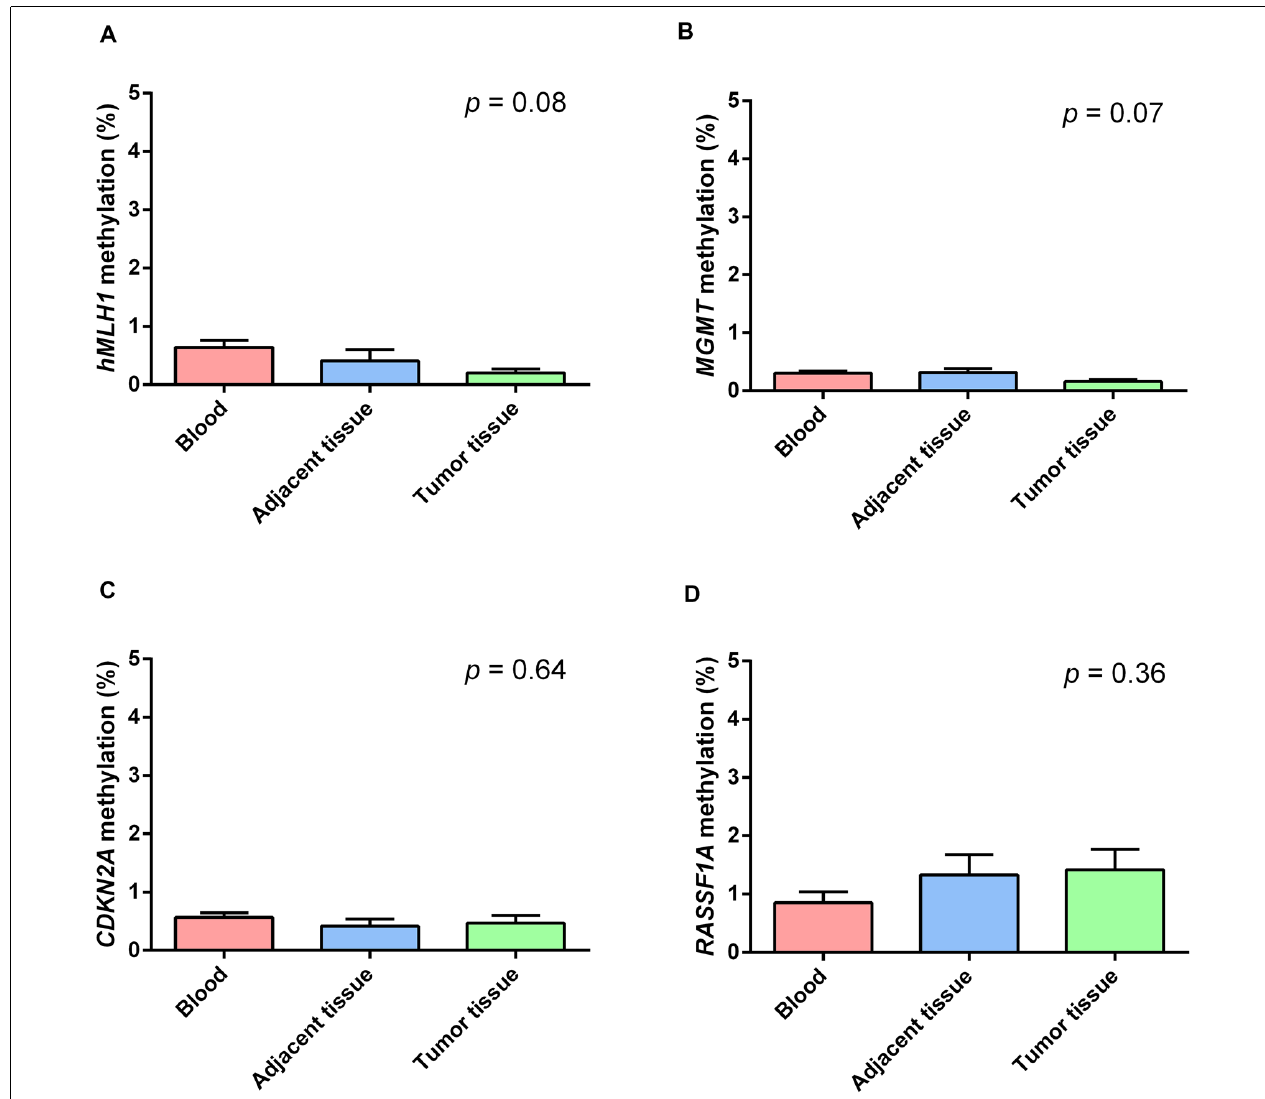
FIGURE 2 | Methylation levels of the studied genes in blood (red), healthy thymic tissue (blue), and tumor tissue (green). (A) MLH1 . (B) MGMT . (C) CDKN2A . (D) RASSF1A . All the investigated genes resulted largely hypomethylated in the studied tissues, and no significant difference among them was observed. Data are shown as means ± SEM (mean standard error), and for each gene, we compared 69 blood samples, 69 thymomas, and 44 healthy thymuses. The p value reflects the Bonferroni’s corrected p value of the comparison of mean methylation levels among the three